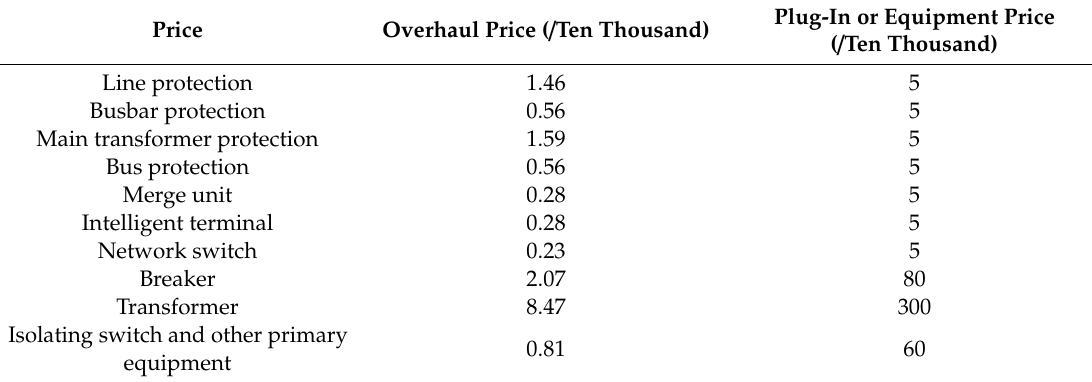
Table 6. Price and maintenance cost of primary and secondary equipment.